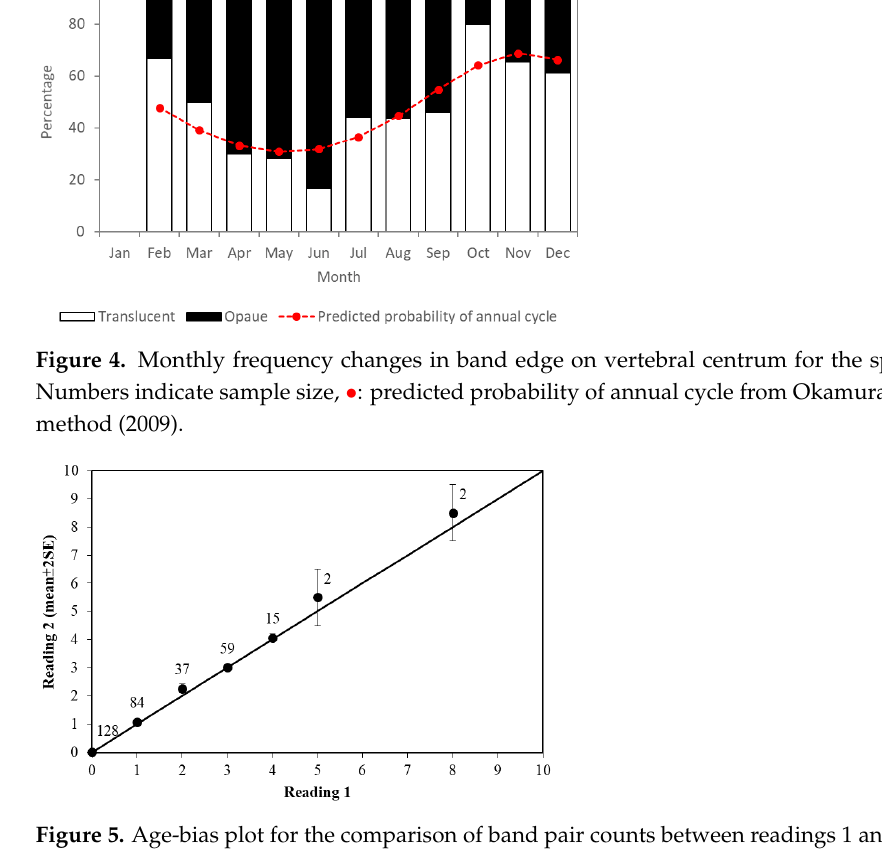
Figure 5. Age-bias plot for the comparison of band pair counts between readings 1 and 2 (±2 SE).